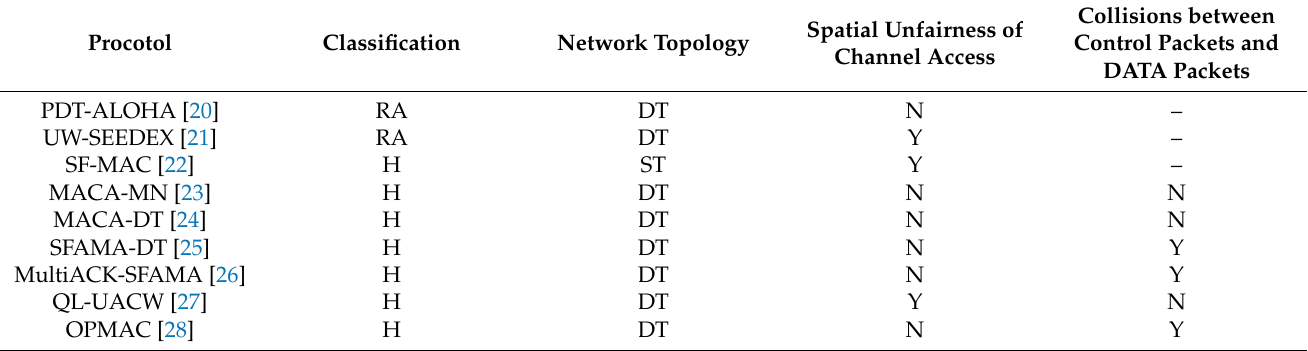
Table 1. Summary of the contention-based MAC